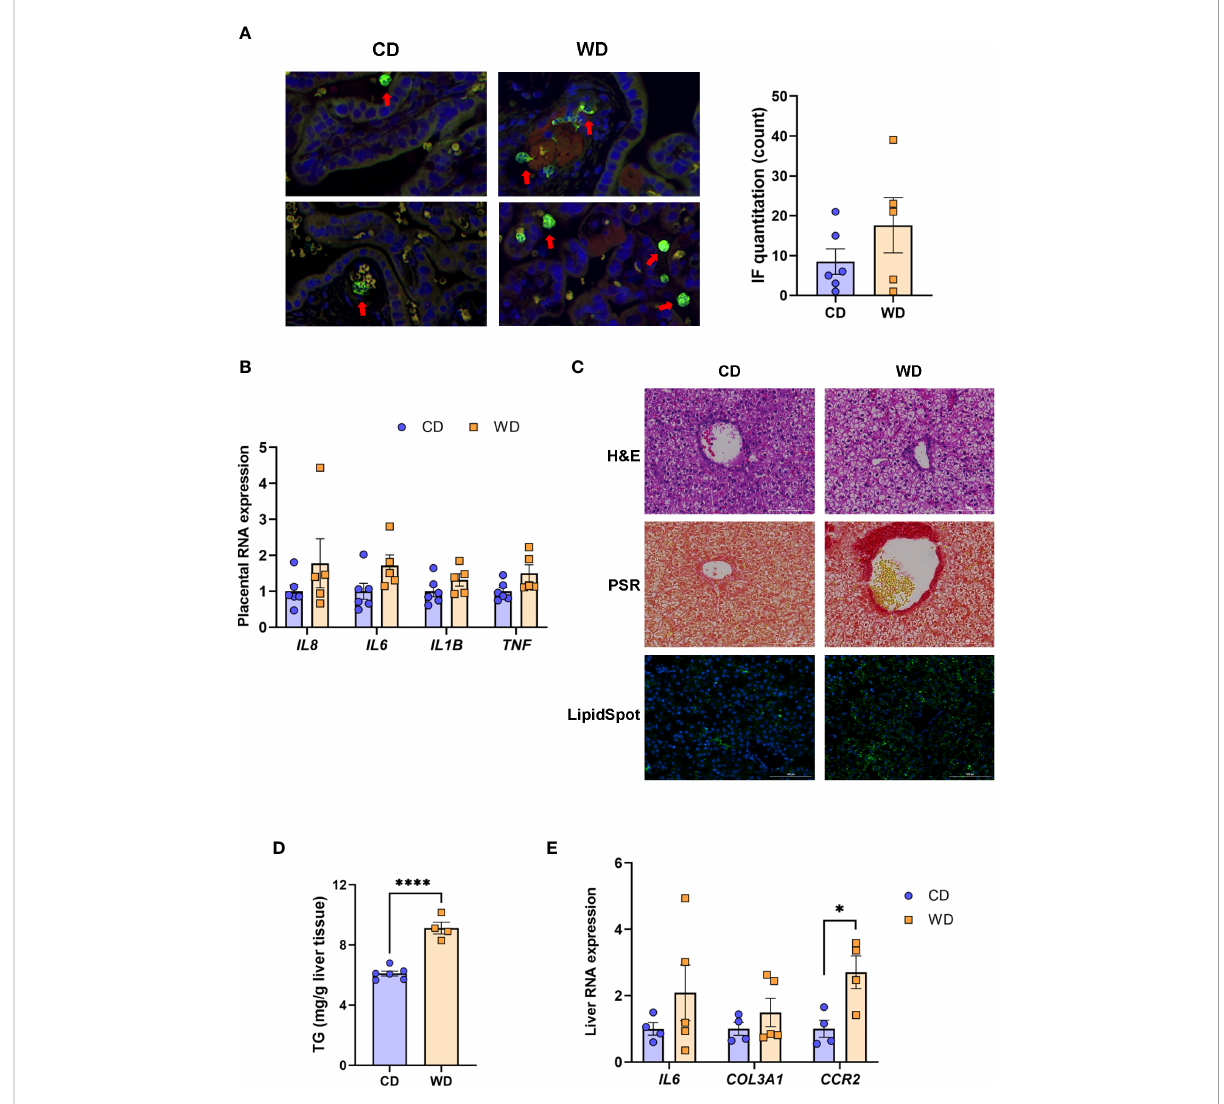
FIGURE 2 WD exposure increases monocyte in fi ltration of the placenta and induces fetal hepatic steatosis and fi brosis. Representative images for immuno fl uorescence in placenta tissue and quantitation (A) . Red arrows point to MAC387-labeled macrophages (green). Blue staining - DAPI. (B) mRNA expression of cytokines in placenta using qPCR. ACTB was used for reference. Representative images of histological analysis of fetal liver tissue (C) with H&E, picrosirius red (PSR), and LipidSpot, taken at 100 um. Fetal liver triglycerides (TG) (D) and mRNA expression analysis using qPCR (E) with RPS9 used for normalization. n = 4-6 CD and n = 5 WD. Unpaired 2-tailed Student ’ s t test was used to test signi fi cance. * P < 0.05, **** P <